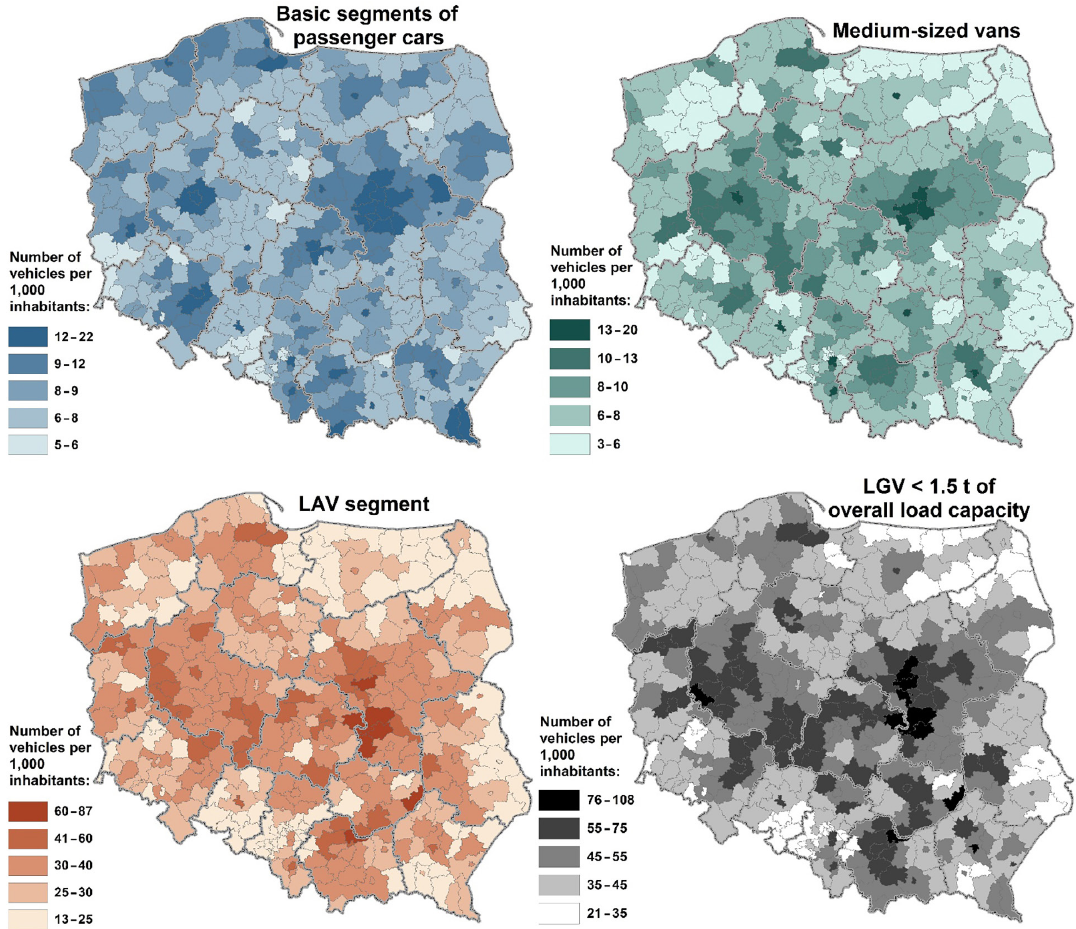
Fig. 4. Spatial distribution of LGVs (permissible load capacity <1.5 tonnes) in Poland by three selected groups (as at 31 December 2018). LGV – large goods